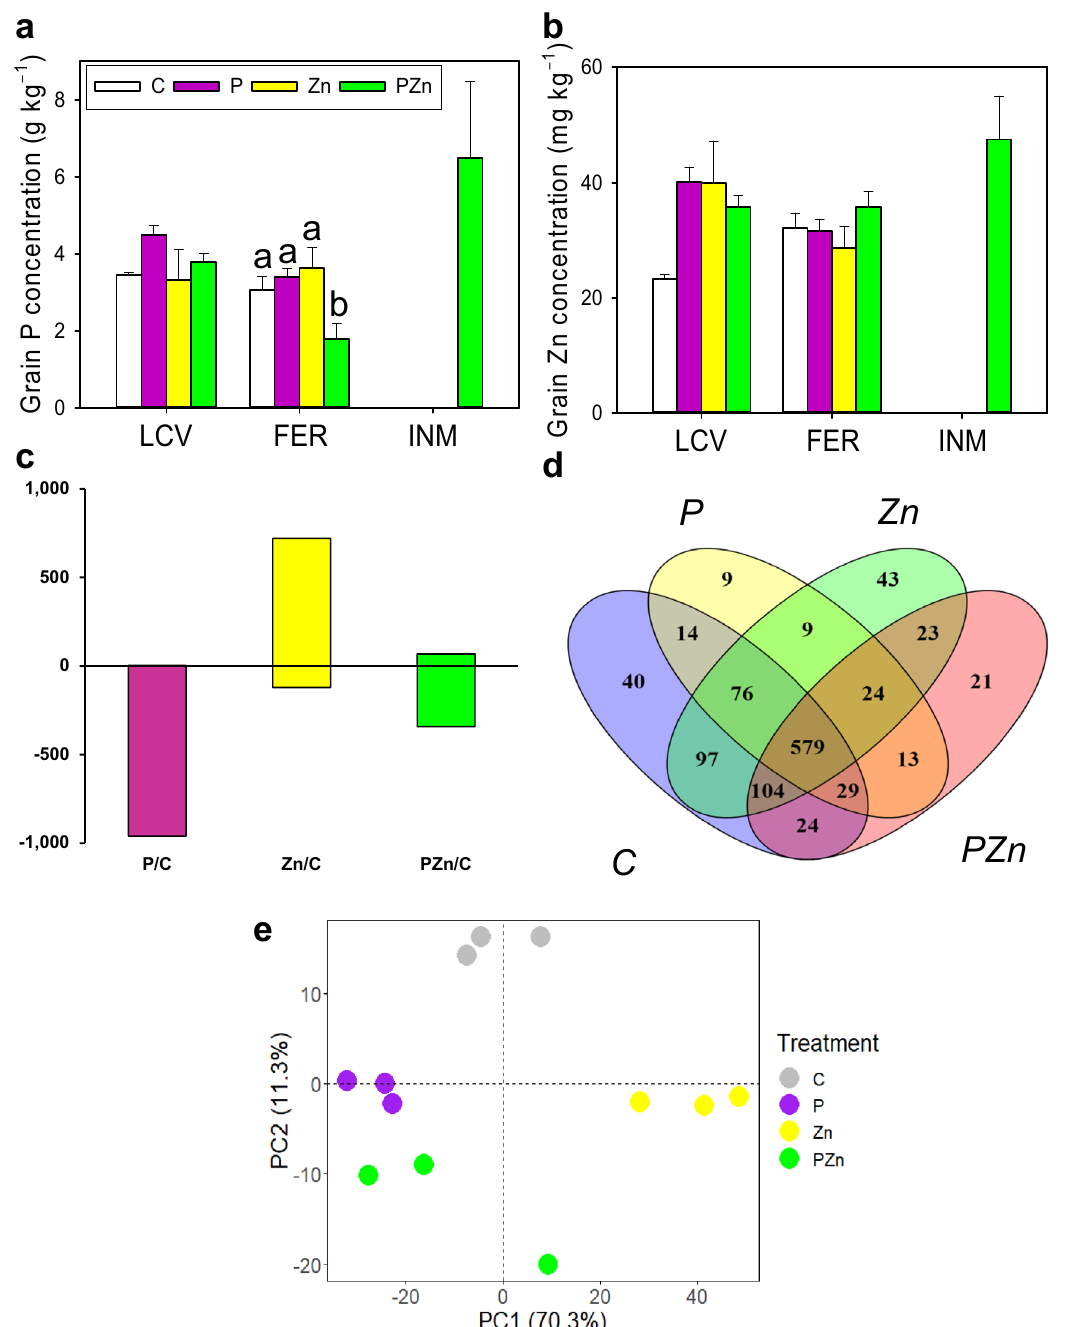
Figure 2. Grain P ( A ) and Zn ( B ) concentration (mean ± standard error, n = 4) at harvest as a function of soil and treatment. ( C : no P or Zn was added; P : fertilization with 40 mg P kg −1 but no Zn; Zn : fertilization with 3 mg Zn kg −1 but no P; PZn : fertilization with 40 mg P kg −1 and 3 mg Zn kg −1 ). Different letters indicate significant differences between treatments according to the post-hoc LSD test. No letter means there were no significant differences. ( C ) Ratio of grain proteins whose abundance at harvest was greater or less than with treatment C . Number of up- and down-accumulated proteins represented as positive and negative values, respectively. ( D ) Venn diagrams showing all differentially abundant grain proteins altered by fertilization with P and/or Zn. ( E ) PCA exposing differences in grain proteomic profile between treatments. The proteomic analysis was conducted on three biological replicates ( n =